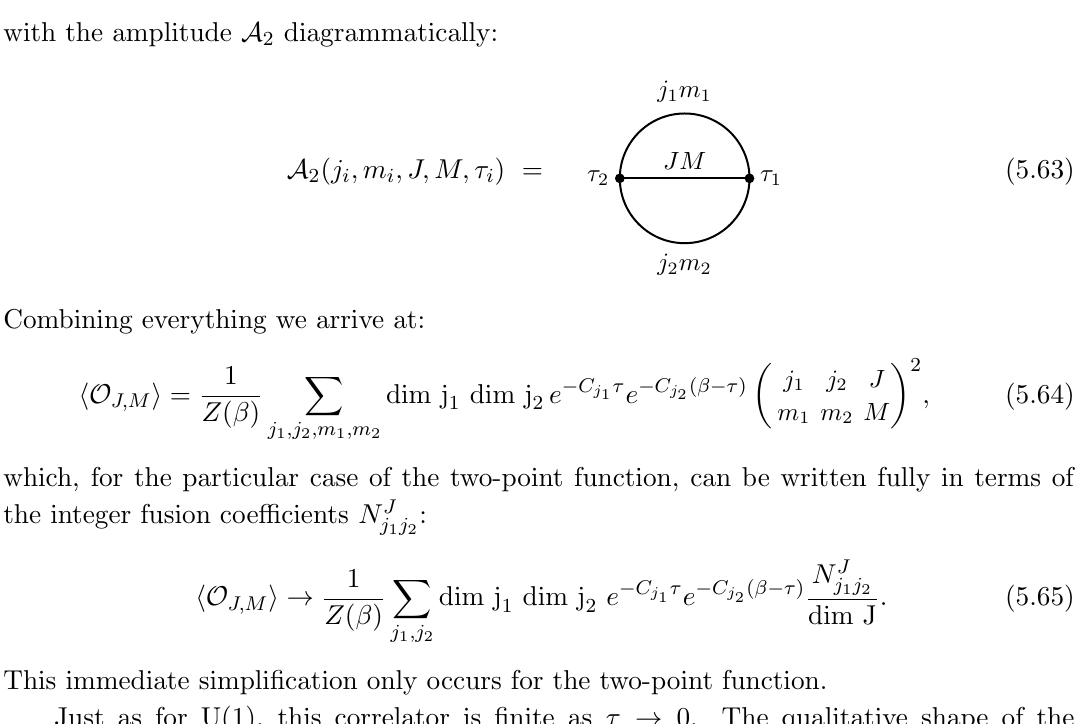
Figure 13 . Two-point function of SU(2) theory (5.65) in units where (cid:12) = 1 for several values of J : J = 0 (red), J = 1 (orange), J = 3 = 2 (yellow), J = 2 (green), J = 5 (blue), J = 7